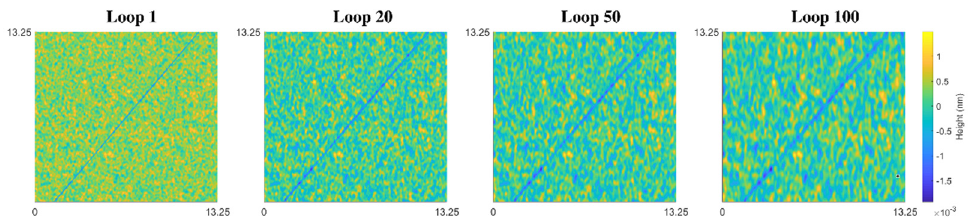
Figure 7. Simulated surface morphology for chemical material removal within 101 loops by ran- domly selected particles (sampling points: 500 × 500 within a 13.25 μ m × 13.25 μ m range in the x–y direction).